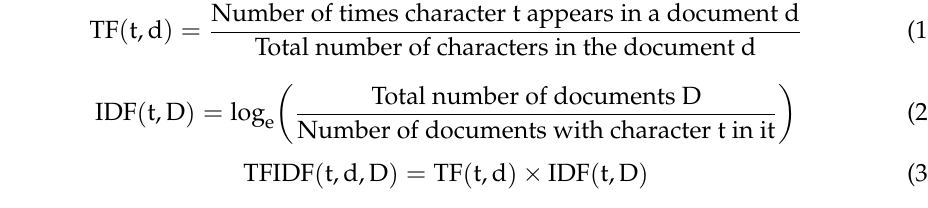
Table 1. Major data sources for detecting phishing websites. Data Source